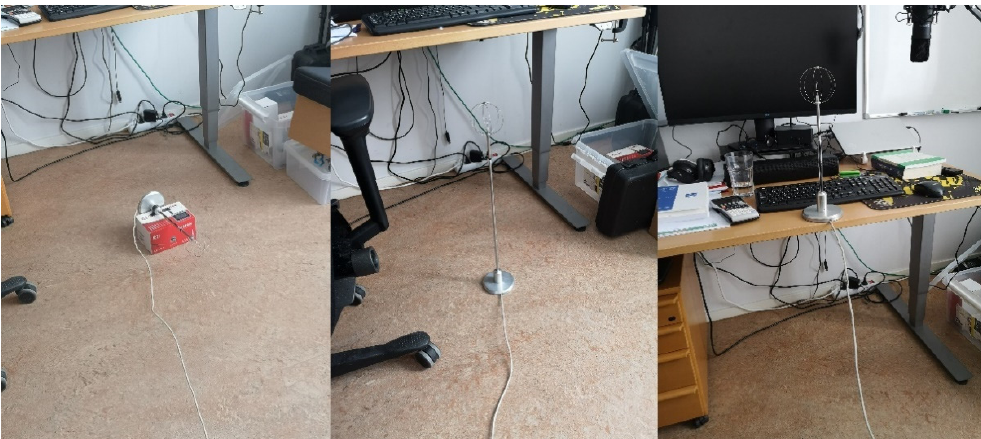
Figure 15. Air velocity measurements at 0.1, 0.6, and 1.1 m in Room